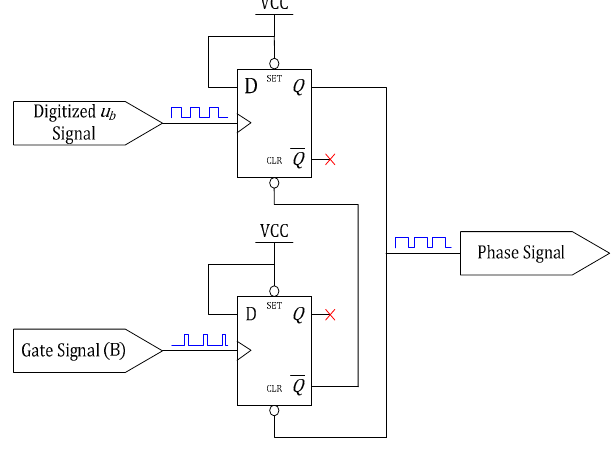
Figure 11. Structure of the D flip-flops-based detector.